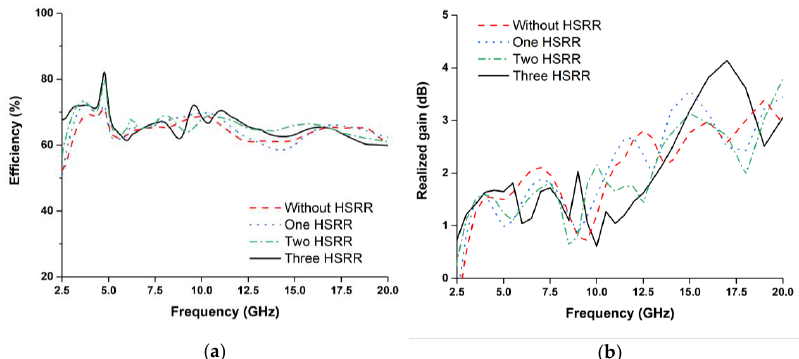
Figure 10. Simulated ( a ) efficiency and ( b ) realized gain of the UWB antenna for different orientations.